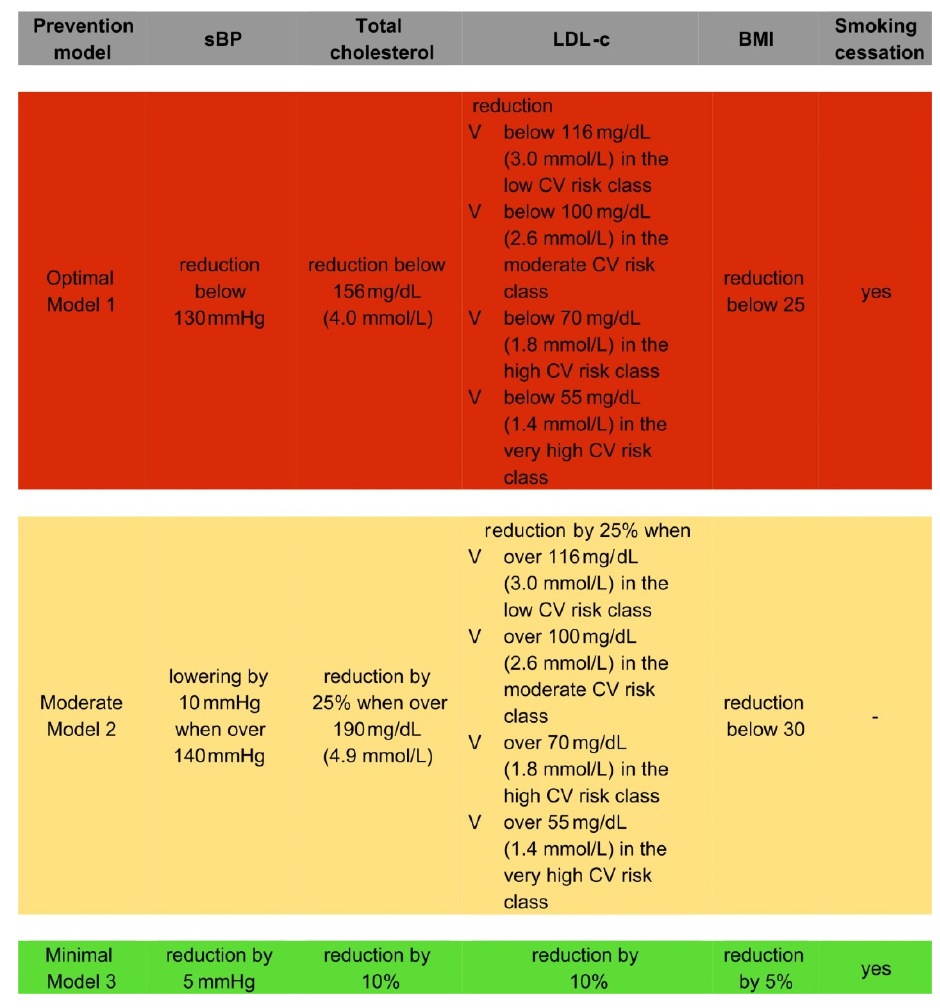
Figure 1. Prevention models designed.